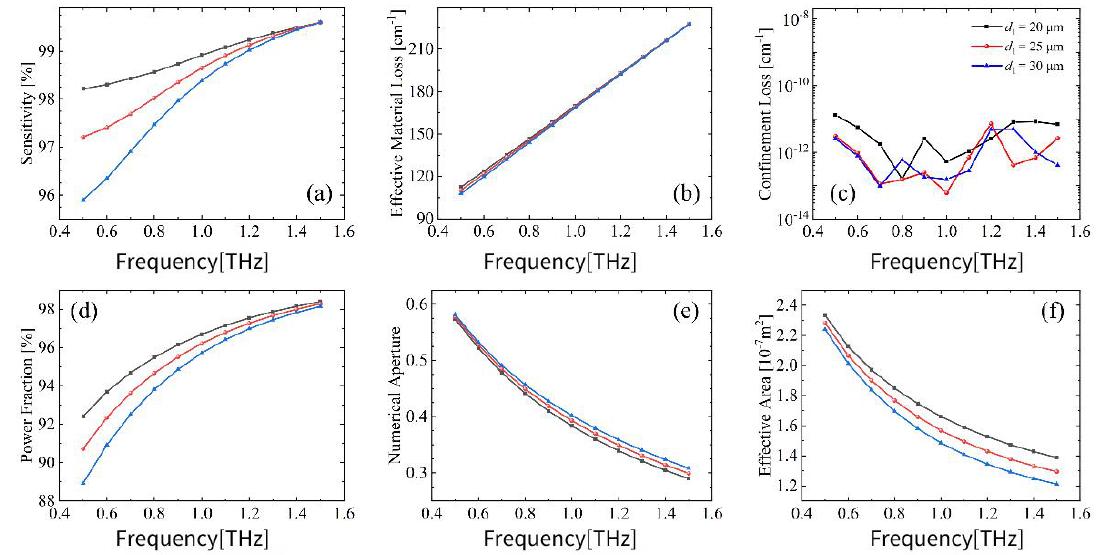
Figure 6. Behavior of ( a ) sensitivity, ( b ) EML , ( c ) CL , ( d ) core power fraction, ( e ) NA , and ( f ) A eff relative to frequency for different fill-in factors when D core = 800 µ